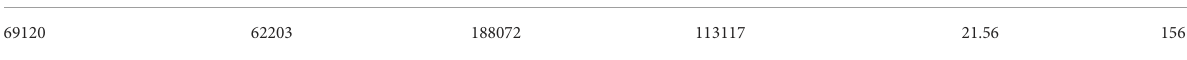
TABLE 1 The results of citation analysis of 8569 articles.